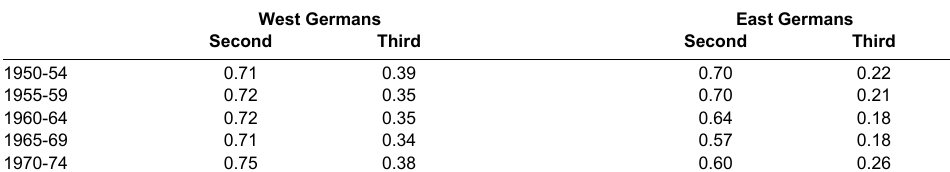
Table 1a : Parity progression ratio for second and third births, by birth cohort and region West Germans East Germans Second Third Second Third 1950-54